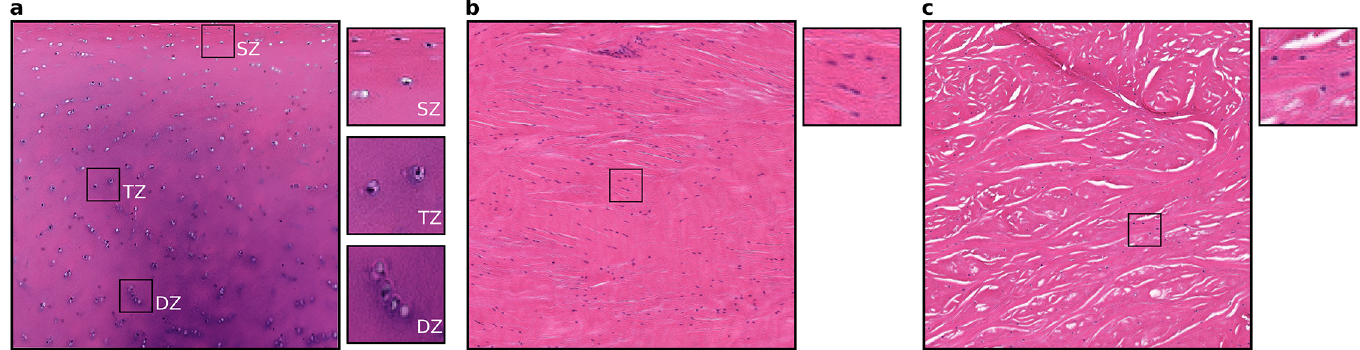
Fig 9. Histology sections for various tissues of the tibiofemoral joint. a) Femoral medial articular cartilage with sections from superficial (SZ), transitional (TZ) and deep (DZ) zones illustrating zonal variations in cell distributions. b) Lateral collateral ligament. c) Medial meniscus. The large sections are approximately 1 mm x 1 mm and the small sections are approximately 100 μ m x 100 μ